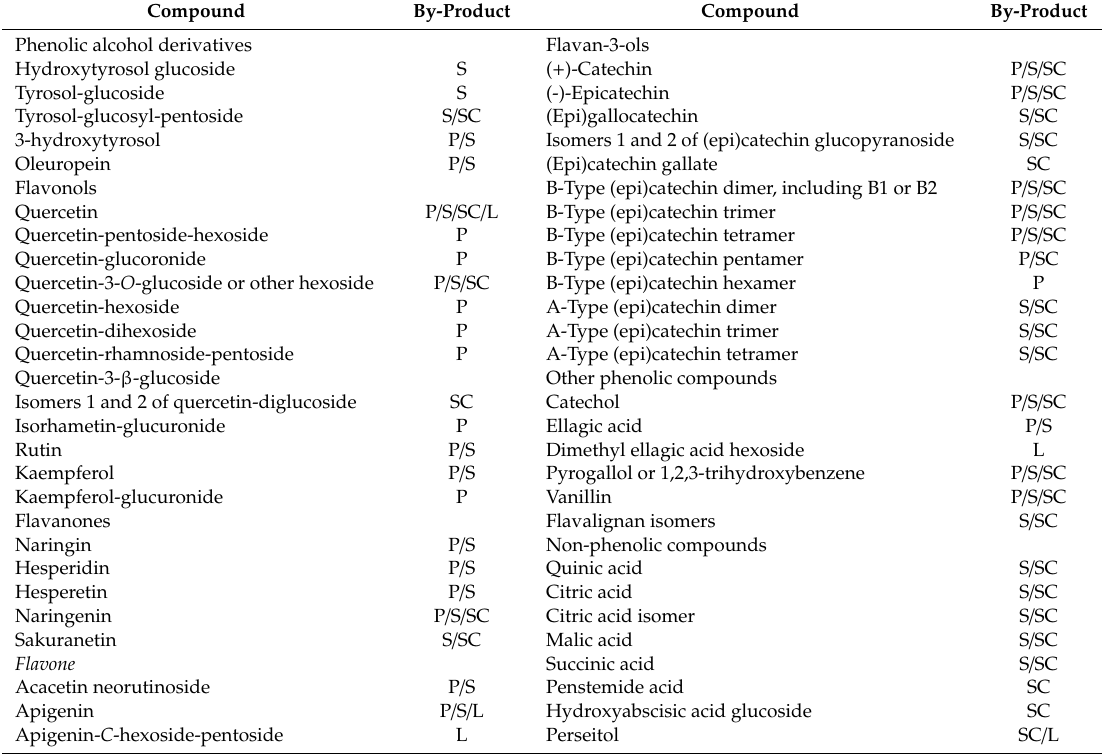
Table 6. Phenolic compounds and other compounds characterized in avocado waste according to